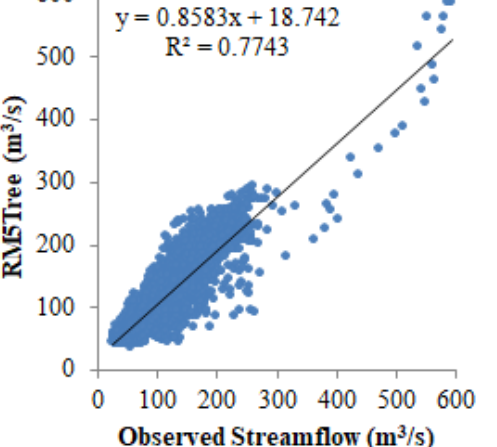
Figure 10. Time scatterplots of the observed and estimated streamflow of Skallbole Station (down- stream) by RM5Tree, M5Tree, RBFNN, ANN, and MARS models in the test period using data of Ostavallselet Station (upstream).